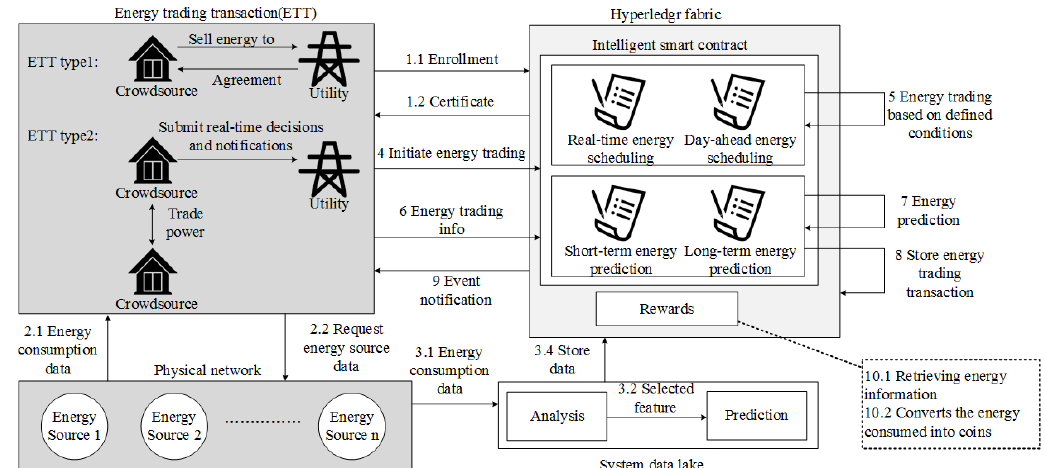
Figure 30. Reconstruction diagram of reference [60].